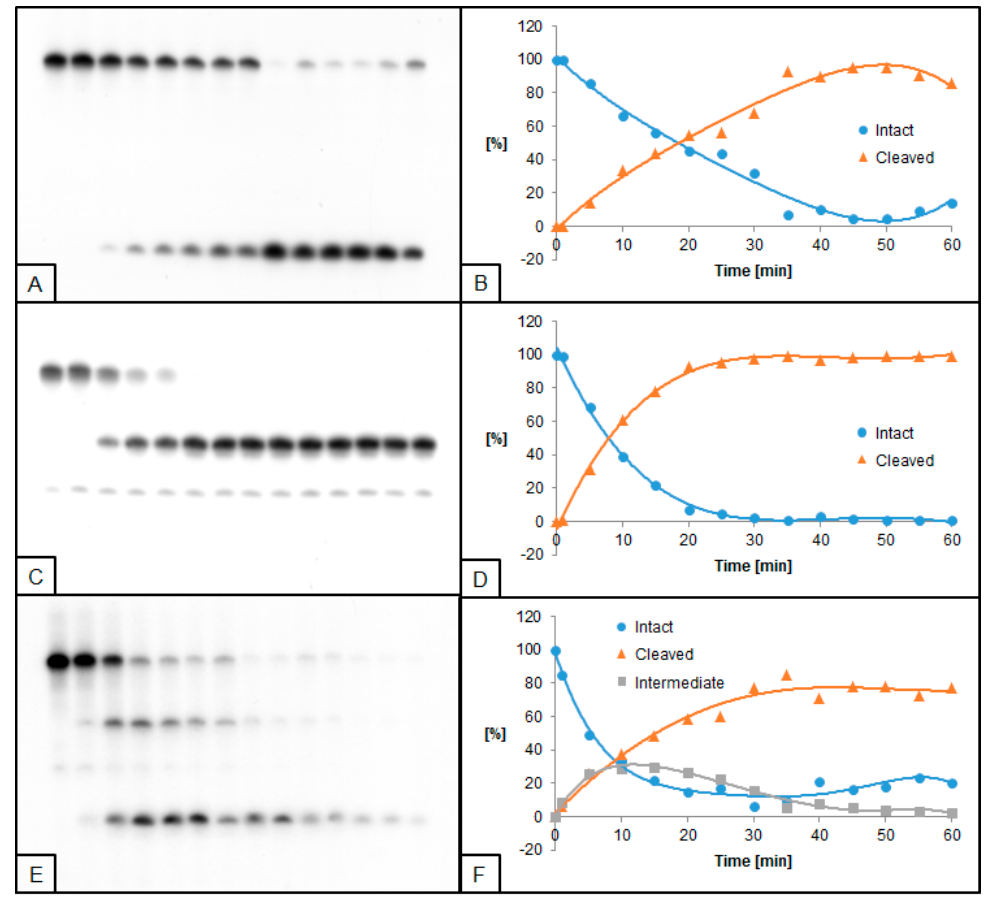
Figure 7. Cleavage of dsDNA containing dU and (5 ′ R ) − 5 ′ ,8-cyclo-2 ′ -deoxyguanosine (RcdG) by 0.02 U UDG and 0.5 U hAPE1. ( A , B ) dU( − 5)RcdG; ( C , D ) dU(+5)RcdG; ( E , F ) dU( − 5)(+5)RcdG. ( A , C , E ) show 14 lanes each, which correspond to reaction times 0, 1, 5, 10, 15, 20, 25, 30, 35, 40, 45, 50, 55, and 60 min starting from the left. ( B , D , F ) show the quantity loss of intact ssDNA (blue), the quantity increases of SSB-DNA (orange), and an intermediate oligo fragment (grey).